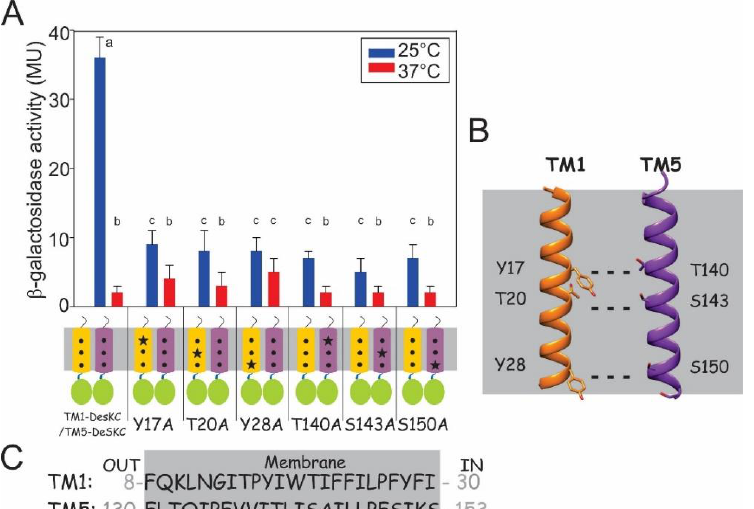
Figure 2. ( A ) TM1-TM5 interhelical hydrogen bonds are required for signaling. Bacillus ∆desk cells expressing the co-expression system TM1-DesKC / TM5-DesKC and variants with the indicated mu- tations were grown as described in Figure 1C. β-galactosidase activity was measured and expressed in Miller units (MU). In the bottom panel, different TMSs are represented as cylinders, the hydrophilic residues (Y17, T20, Y28, T140, S143 and S150) are highlighted with a light-blue dot, and the respective mutations with a black star. Error bars include the standard deviation from at least three independent experiments. There is not significant difference among activities labeled with the same letter. There is significant difference among activities labeled with different letters; ( B ) Molecular graphic of TM1 and TM5 showing the proposed hydrogen bonds between TM1 and TM5. Helices were drawn with UCSF Chimera Software, developed by the Resource for Biocomputing, Visualisation and Informatics at the University of California, San Francisco, with support from NIH P41-GM103311 [21]; and ( C ) Sequence of TM1 and TM5 with the number of the first and last residue of each TMS. The rectangle shows the transmembrane region boundaries according to the bioinformatic software SOSUI and the curated database Uniprot (ID code: O34757).